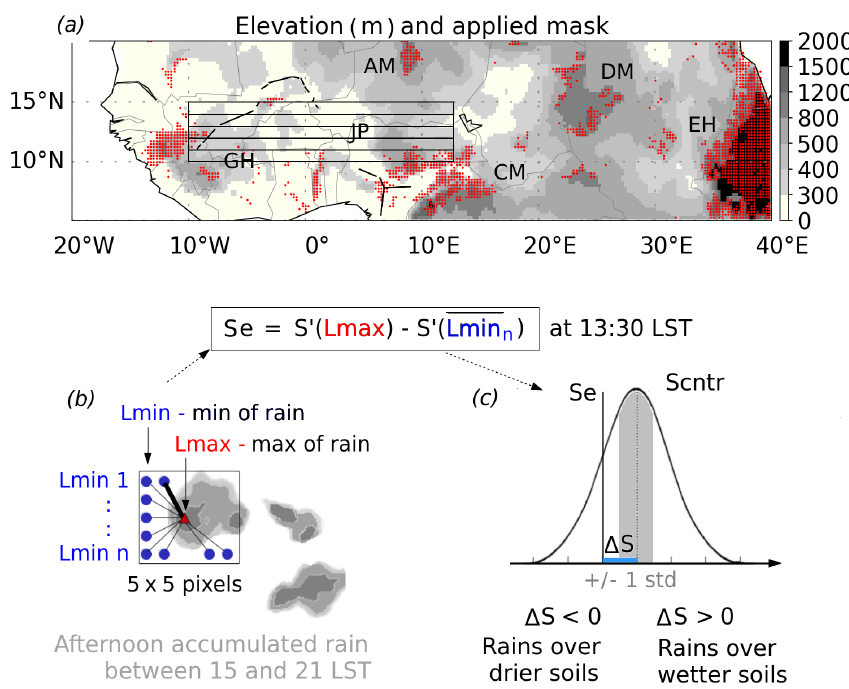
Figure 1. Study area and summary of the methodology. ( a ) Study domain in North Africa; the color-scale indicates elevation (m); black lines mark major rivers; and the orography mask is shown in red shading. The main orographic features in the region are the Air Mountains (AM), Darfur Mountains (DM), Ethiopian Highlands (EH), Cameroon Mountains (CM), Jos Plateau (JP) and Guinea Highlands (GH). The five smaller domains marked with black rectangles indicate the areas selected for the analyses of atmospheric conditions over the relatively flat West African region. ( b ) Schematic representation of afternoon rainfall event geometry. ( c ) Generalized example illustrating the calculation of the deviation, ∆ S , of the observed spatial soil moisture gradient, Se , from the expected value of climatological soil moisture gradients, S cntr , for an individual rainfall